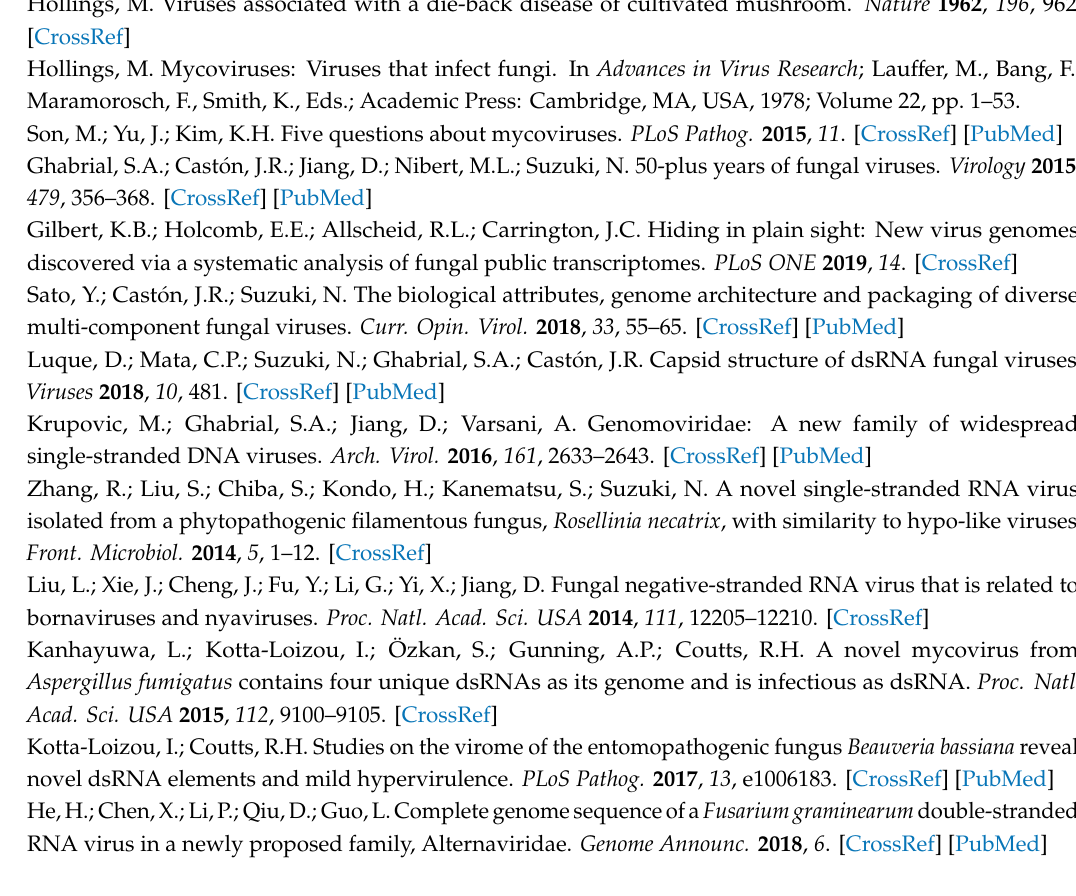
Figure S1: Predicted secondary structures (2-D representation of this self-folding) of the terminal untranslated regions (UTR) of FvMV1 and